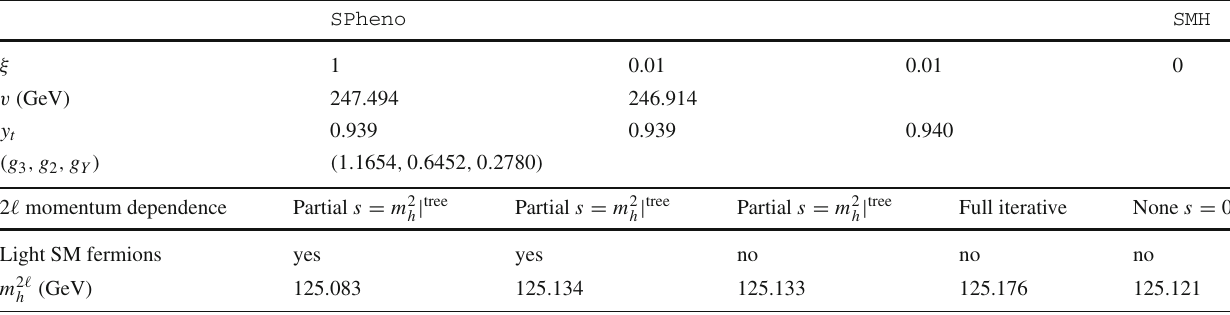
Table 3 Comparison of two-loop Higgs masses calculated with the codes SPheno and SMH , for different choices of gauge in SPheno and switching on and off the two-loop momentum dependence in SMH